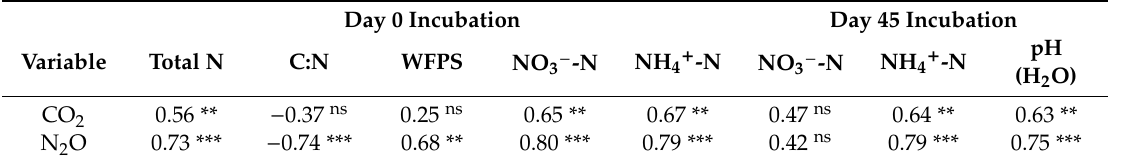
Table 6. Pearson’s correlation coe ffi cients of cumulative N 2 O and CO 2 emissions to di ff erent soil properties in non-amended and amended soils (n = 21) at day 0 and day